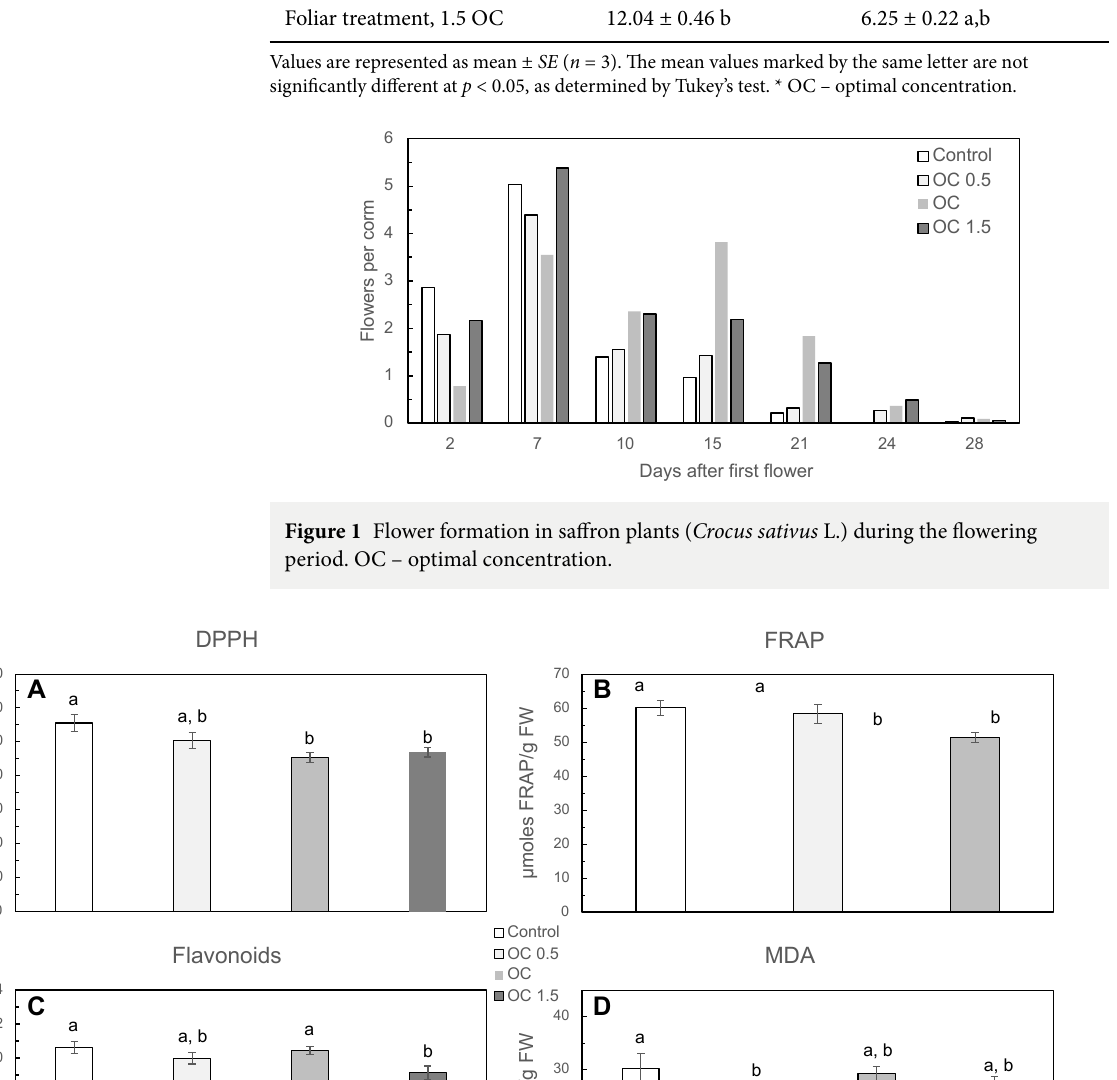
Values are represented as mean ± SE ( n = 3). e mean values marked by the same letter are not significantly different at p < 0.05, as determined by Tukey’s test. * OC – optimal concentration.